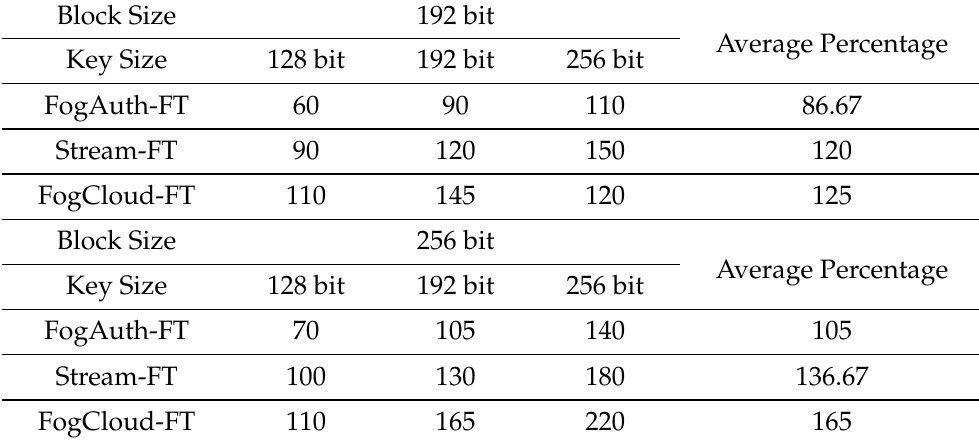
Table 2. Average analysis of FogAuth-FT with a block size of 192 bit and 256 bit.